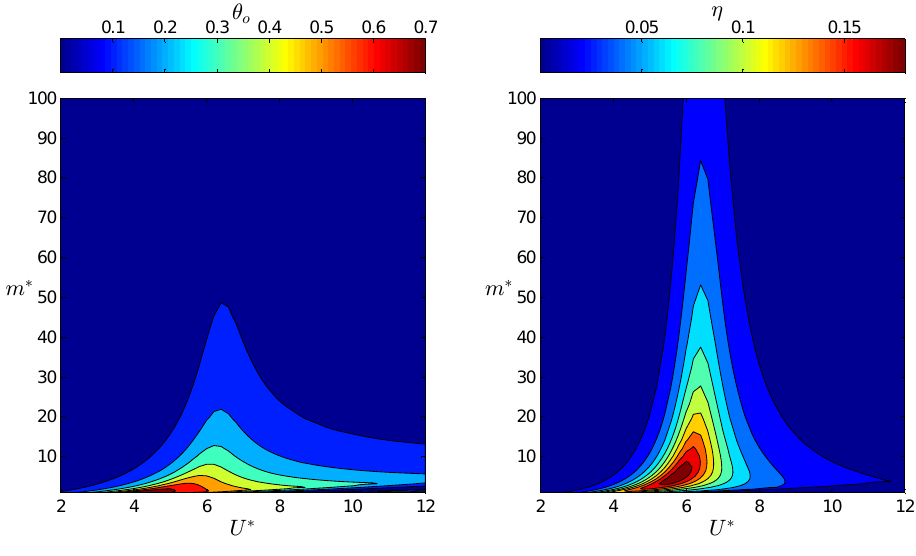
Figure 8. Contours of θ o and η as functions of U ∗ and m ∗ for L ∗ = 0.8 and ζ = 0.01.